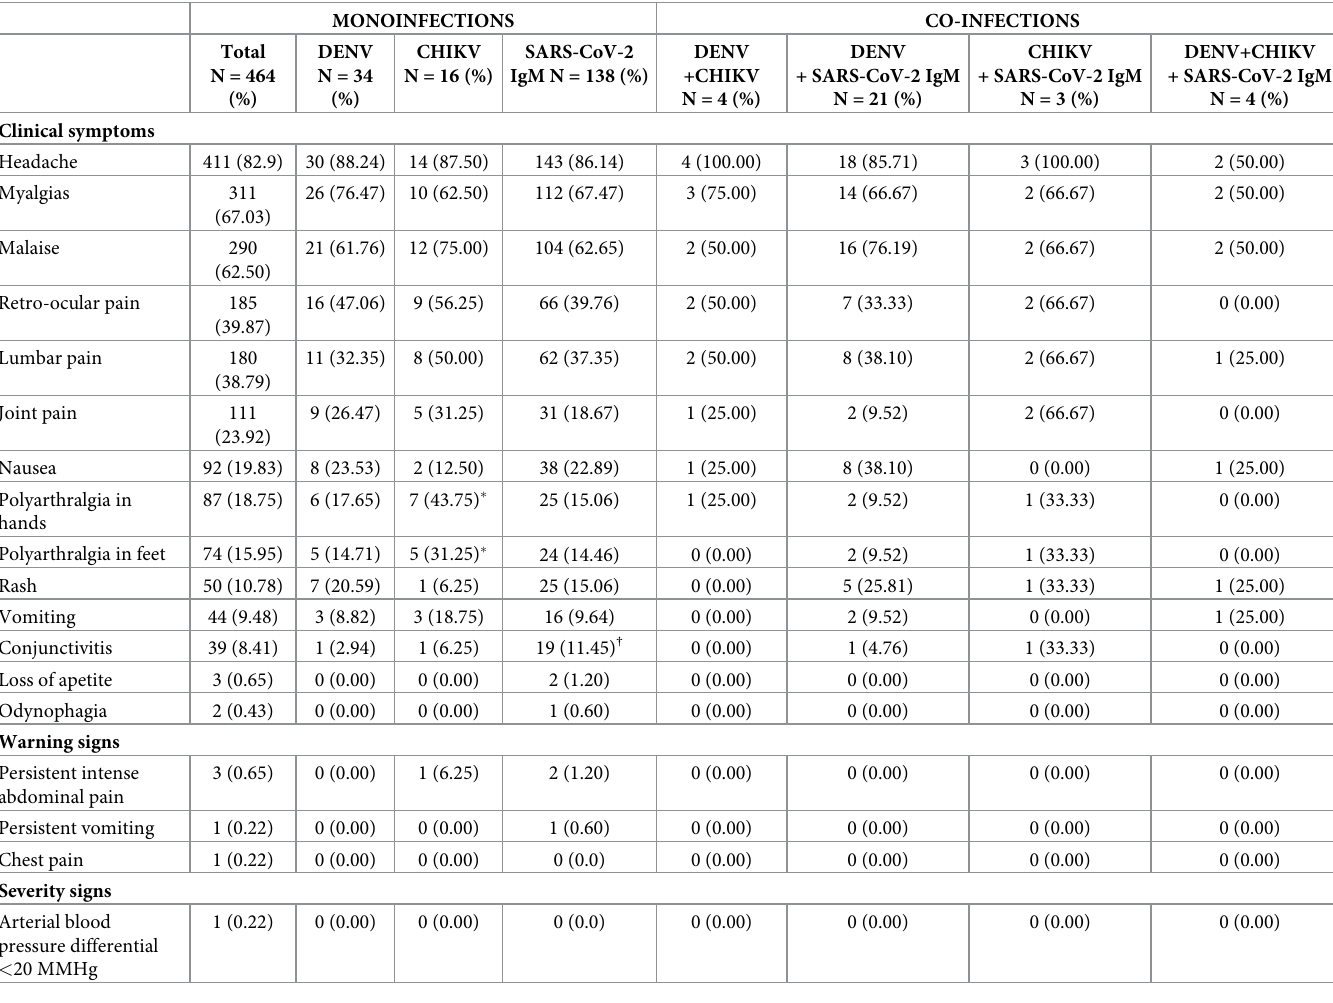
Table 2. Clinical symptoms of patients according the pattern of